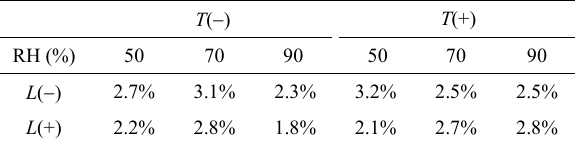
Long-term stability of all tested combinations between number of fiber layers ( L ) and working temperature ( T ) parameters, at 50%, 70%, and 90% of relative humidity. The stability values were given with respect to the relative impedance variations of the systems in the interval of 5 days of measurement, under constant